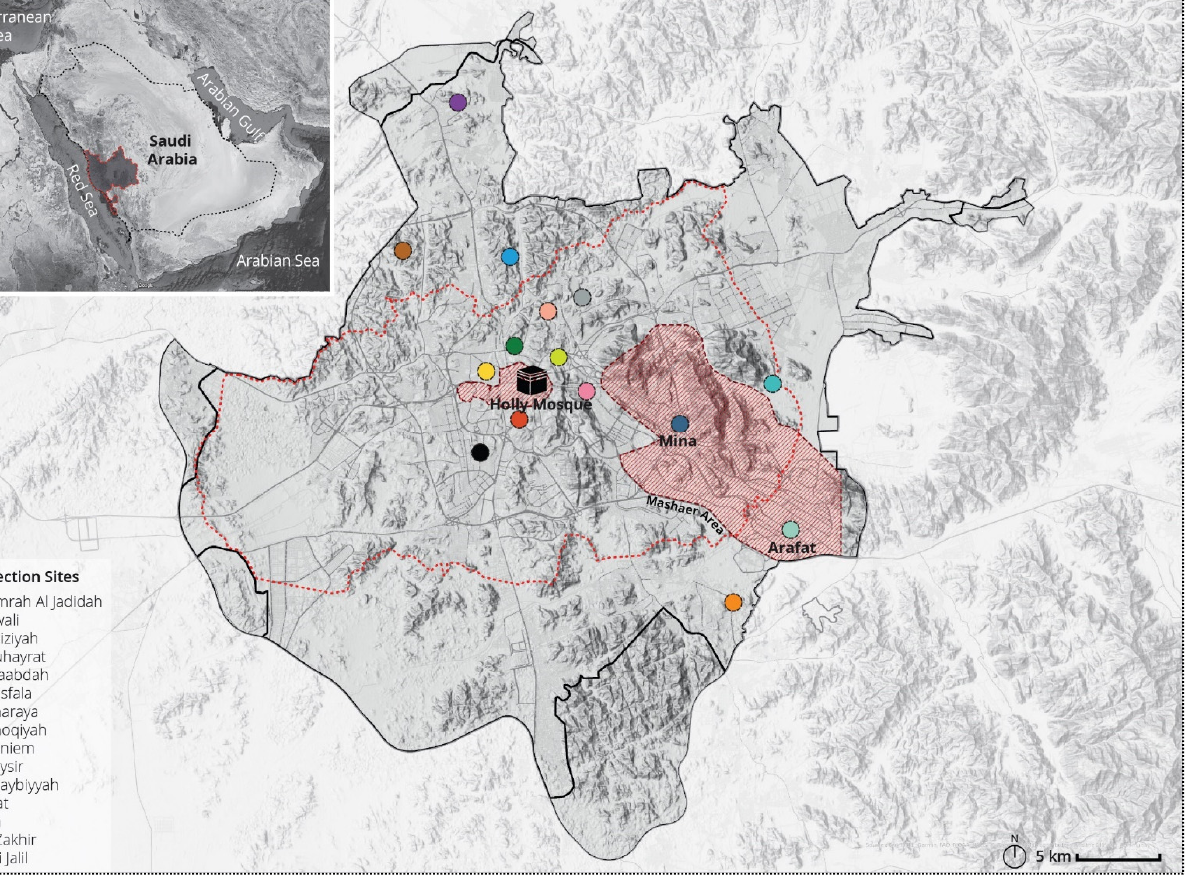
Figure 1. Location of Makkah Province and sites of mosquitoes and larva collection during and post the 2016 Haj j.